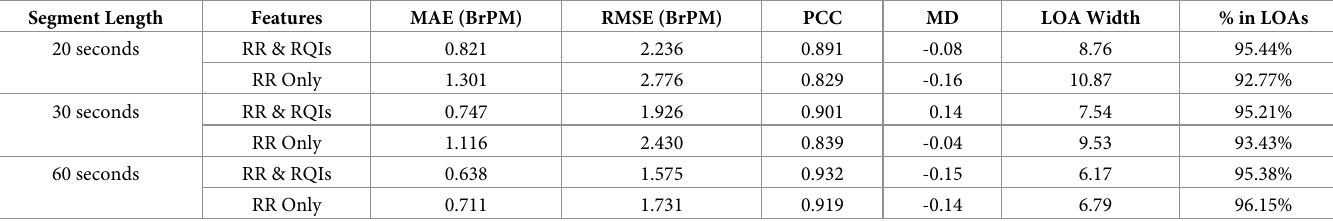
Table 2. Performance of BiLSTM NN using various feature vectors for estimating respiratory rate. Segment Length